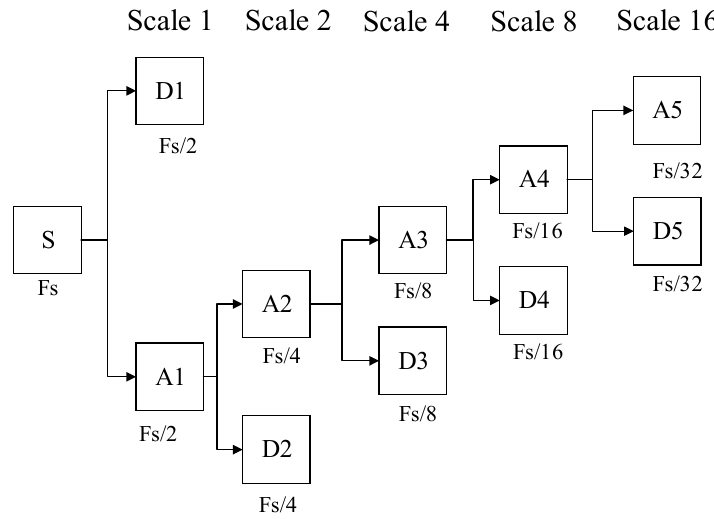
Figure 5. Five-layer multi-resolution analysis structure.